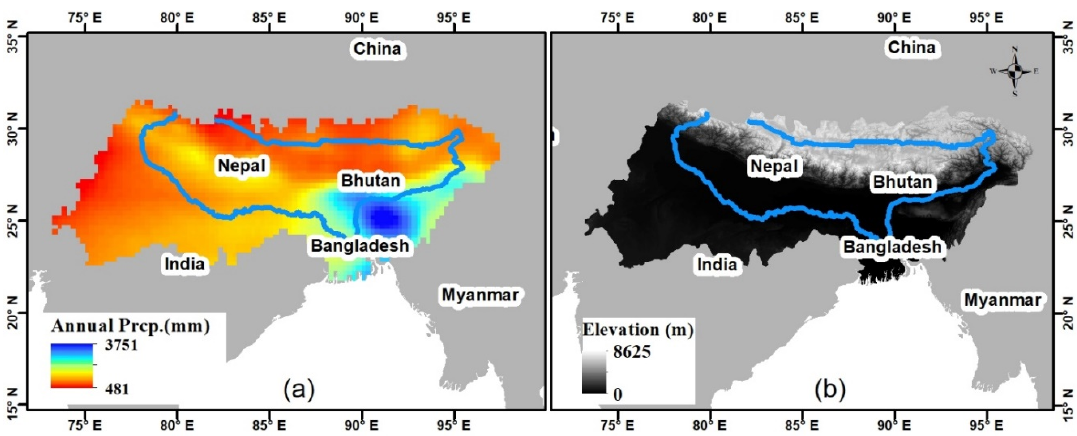
Figure 1. Location of Ganga–Brahmaputra River Basin with average annual precipitation ( a ) and elevation ( b ).